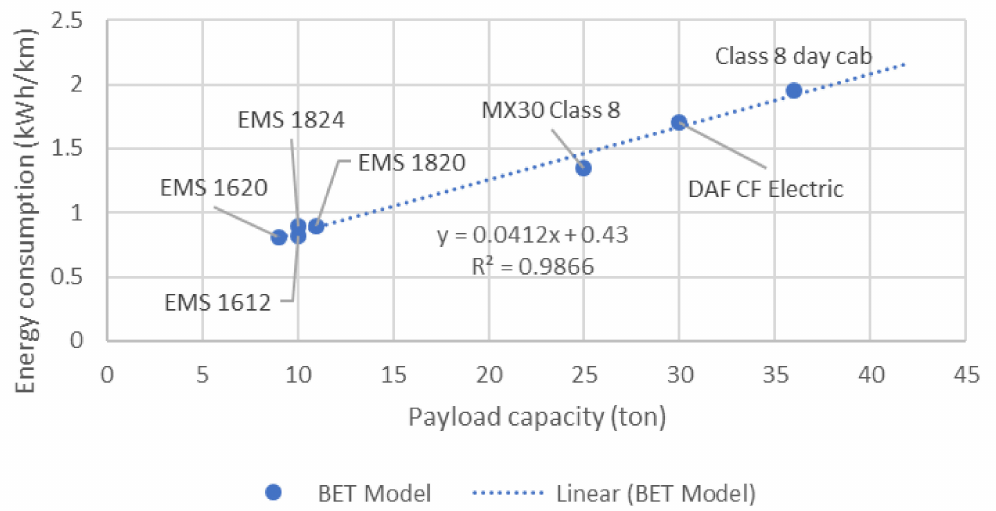
Figure 1. The linear regression model for estimating the energy consumption in battery electric trucks (BETs) with higher payload